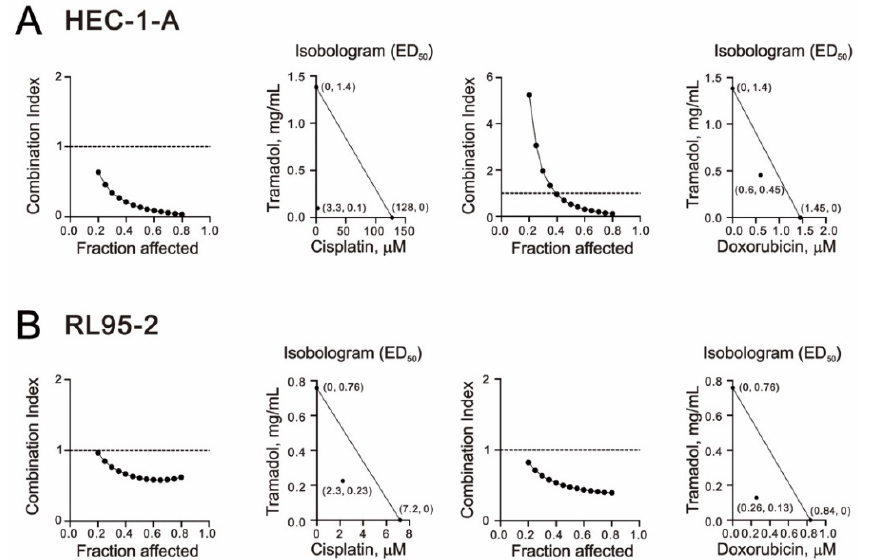
Figure 9. Combination index (CI) of tramadol in combination with cisplatin and doxorubicin in human endometrial cancer cells. ( A ) HEC-1-A cells were treated with tramadol (0, 0.005859, 0.011719, 0.023438, 0.046875, 0.09375, 0.1875, 0.375, 0.75, and 1.5 mg/mL), cisplatin (0, 1.5625, 3.125, 6.25, 12.5, 25, 50, and 100 µ M), and doxorubicin (0, 0.0625, 0.125, 0.25, 0.5, 1, 2, and 4 µ M) for 24 h. ( B ) RL95-2 cells were treated with tramadol (0, 0.003906, 0.007813, 0.015625, 0.03125, 0.0625, 0.125, 0.25, 0.5, and 1 mg/mL), cisplatin (0, 0.3125, 0.625, 1.25, 2.5, 5, 10, and 20 μ M), and doxorubicin (0, 0.0625, 0.125, 0.25, 0.5, 1, 2, and 4 μ M) for 24 h.